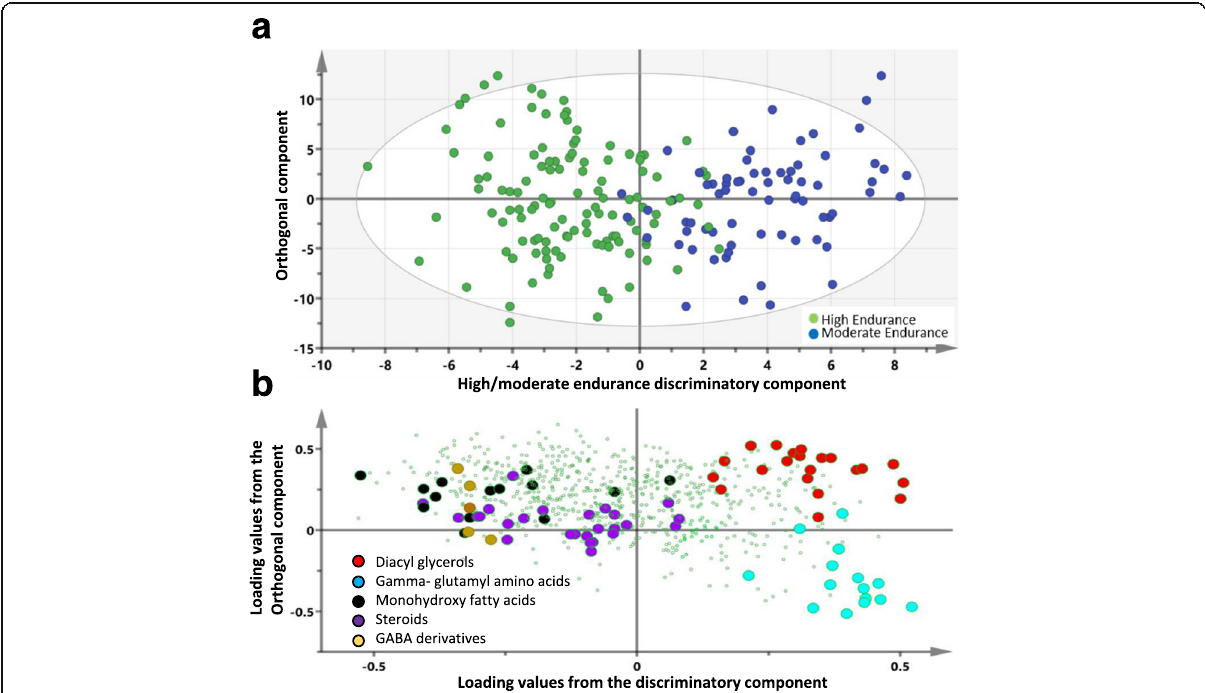
Fig. 2 OPLS-DA model comparing moderate- versus high-endurance classes of elite athletes. a A score plot showing the class-discriminatory component ( x -axis) versus orthogonal component ( y -axis). b The corresponding loading plot showing a clustering of steroids and monohydroxy- fatty acids at the high end of endurance opposed by a clustering of diacyl-glycerols and gamma-glutamyl amino acids at the negative